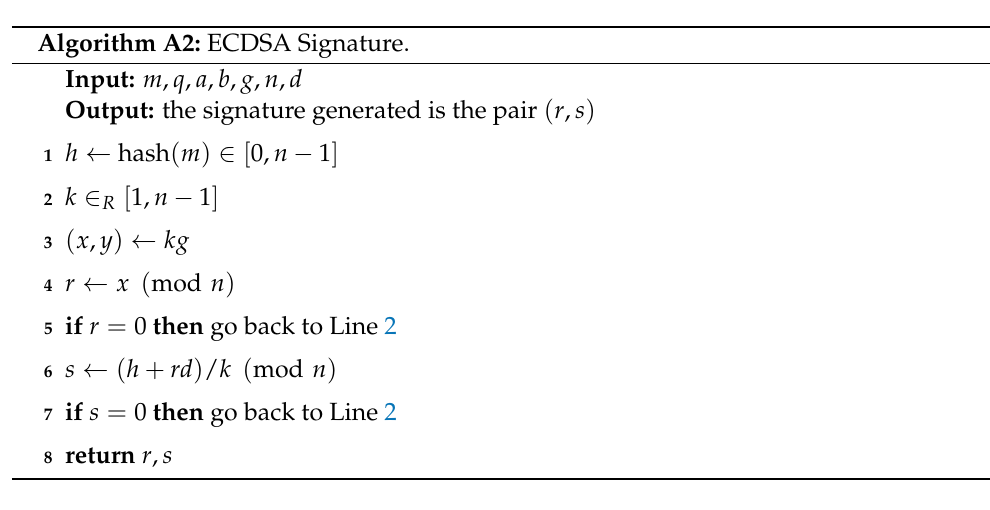
Algorithm A2: ECDSA Signature.